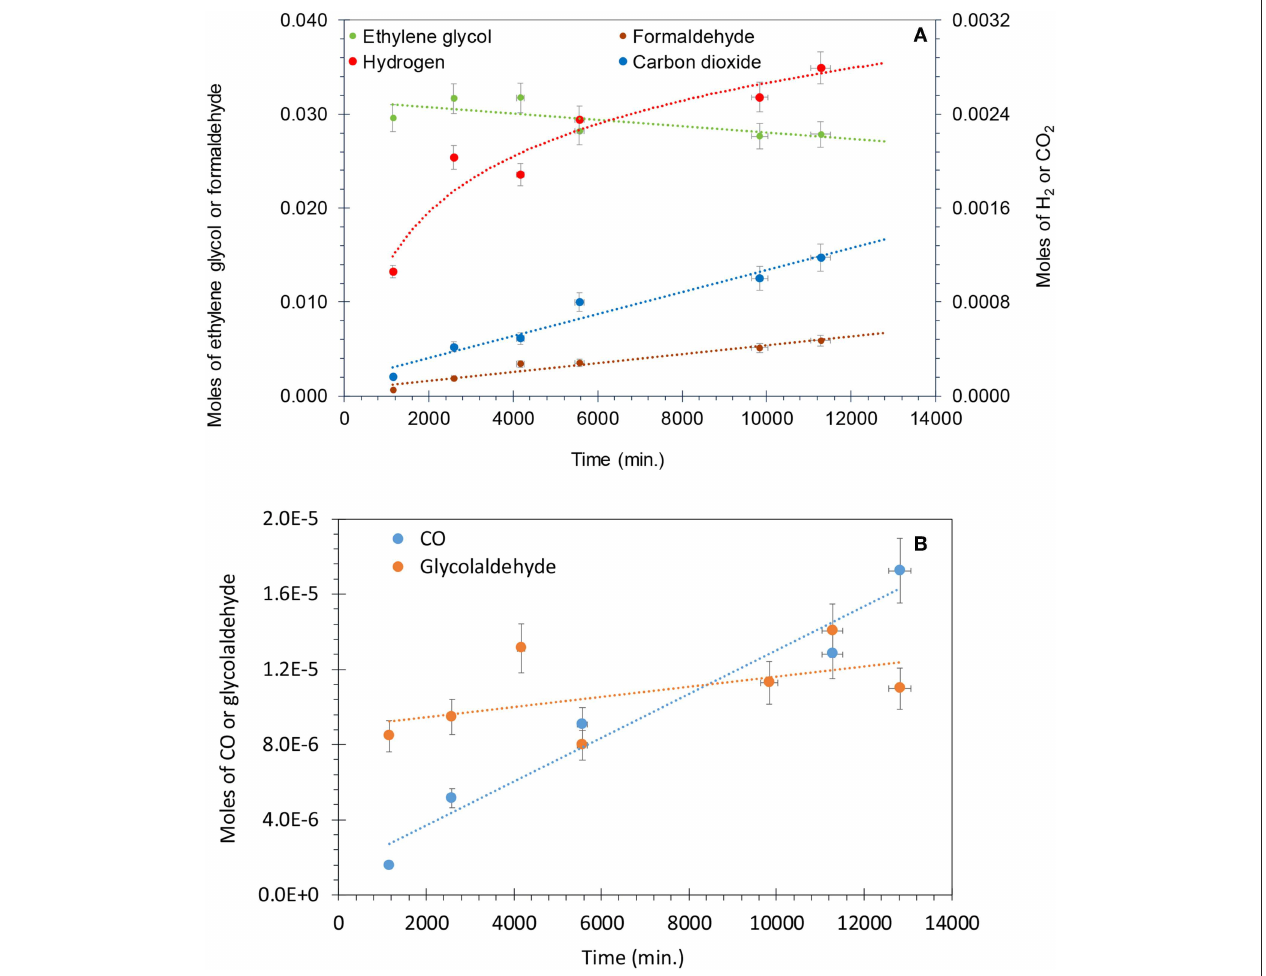
FIGURE 8 | (A) Photo-reforming of ethylene glycol 5 vol.% (0.67M) with 50mg of 0.1 wt.% Ag − 0.3 wt.% Pd/TiO 2 (anatase) catalyst. Formaldehyde and ethylene glycol concentration are from the liquid phase, while H 2 and CO 2 from the gas phase. (B) Production of CO and glycol aldehyde during the photo-reforming of ethylene glycol 5 vol.% (0.67M) with 50mg of 0.1 wt.% Ag − 0.3 wt.% Pd/TiO 2 (anatase)